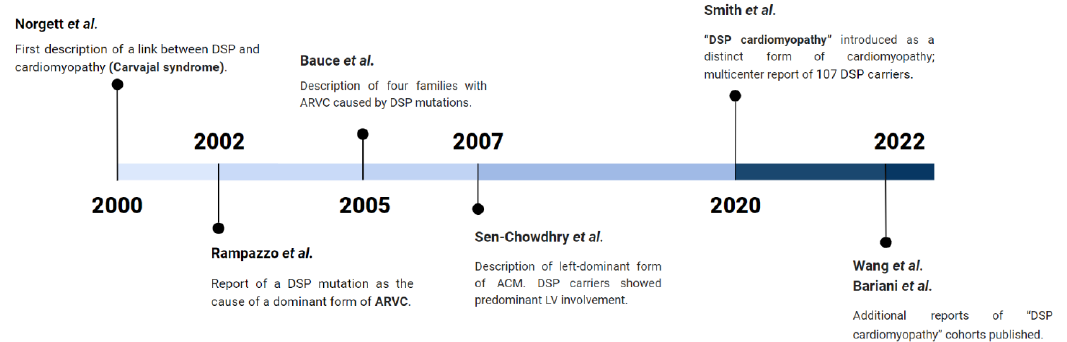
Figure 1. Timeline with landmark studies on DSP cardiomyopathy [3 – 6,17 –